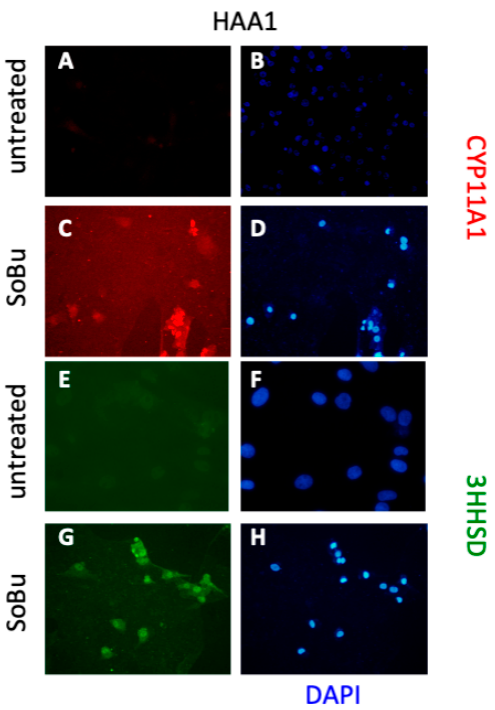
Figure 4. SoBu treatment induces expression of steroidogenic enzymes in HAA1 cells. ( A – H ) Un- treated ( A , B , E , F ) and SoBu-treated ( C , D , G , H ) HAA1 cells were stained either for CYP11A1 ( A – D ) or 3BHSD ( E – H ) protein. DAPI staining shows that cells are present in all fields. Scale bars, 100 μ ( A – D , G , H ) and 50 μ ( E , F ).